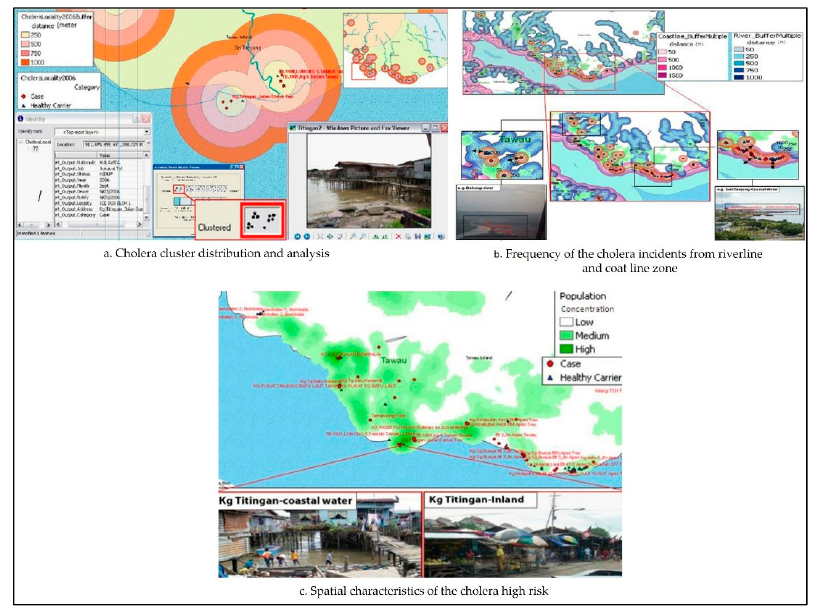
Figure 8. Spatial mapping and analysis of cholera in the Sabah area, Malaysia. (Source: [40]).